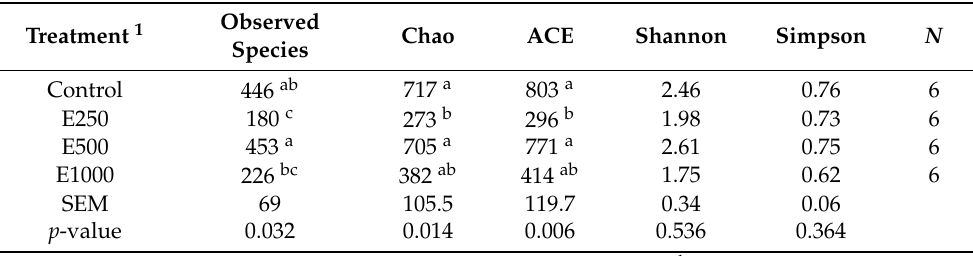
Table 7. The effect of glucose oxidase addition on the alpha diversity indices of ileal microbiota in broilers.